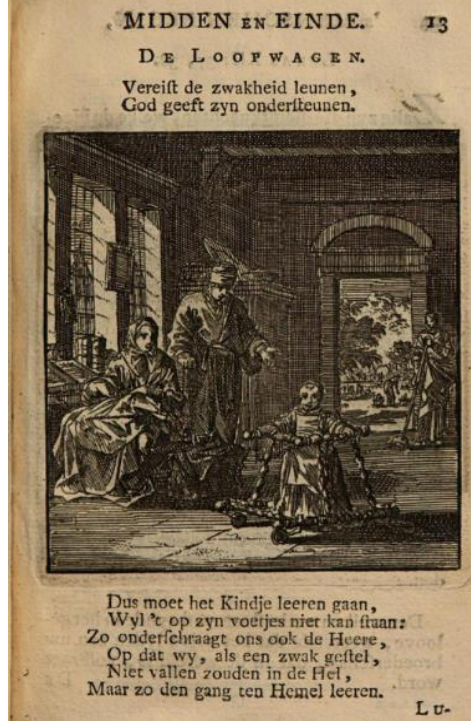
Figure 1. Jan Luyken, Frontispiece, Des Menschen Begin, Midden en Einde , Amsterdam: K.van der Sys. 1712, Engraving.